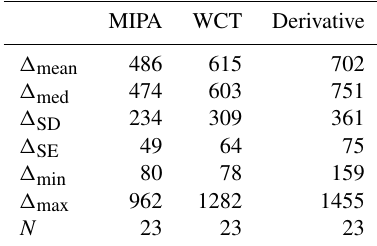
Table 3. Statistical analysis of the absolute differences with re- spect to the reference of the ABLH retrieved by applying MIPA, WCT and derivative approaches on the Évora 72h high-resolution time series of the total attenuated backscatter at 1064nm. The mean ( (cid:49) mean ), the median ( (cid:49) mean ), the standard deviation ( (cid:49) SD ), the standard error ( (cid:49) SE ), the minimum and the maximum of the absolute differences are given in meters. N is the number of points on which the statistics are made. The reference is assumed to be the ABLH calculated from the co-located atmospheric temperature and pressure profiles provided by GDAS forecasts.